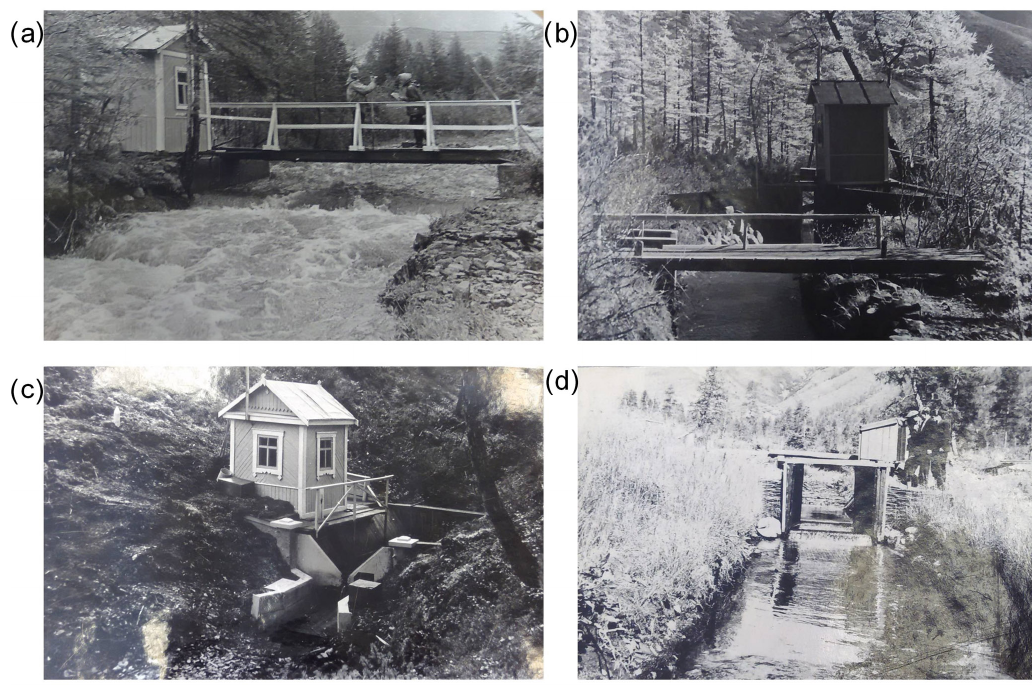
Figure 6. Runoff observations: (a) runoff gauge at the Kontaktovy creek, 1979; (b) runoff gauge at the Dozhdemerny creek, 1959; (c) runoff gauge at the Yuzhniy creek, 1960; (d) runoff gauge at the Vstrecha creek, 1953 (photos from the KWBS archive, provided by S. I.